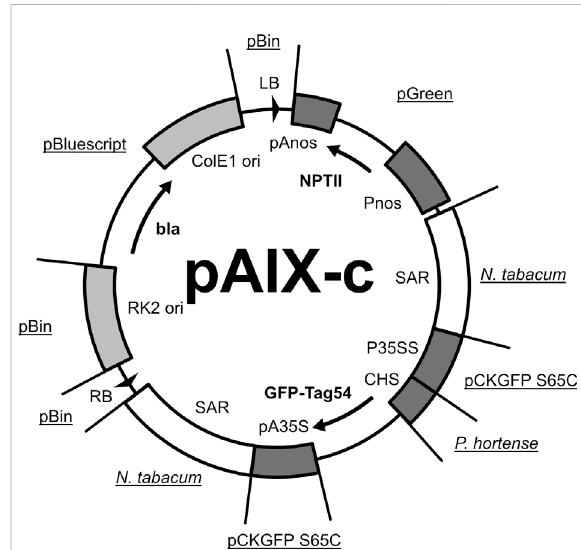
FIGURE 3 IllustrationofthepAIX-cbinaryvectoranditsfeatures.LB:left border of A. tumefaciens T-DNA; RB: right border of A. tumefaciens T-DNA; pAnos: polyadenylation sequence of the nopaline synthase of A. tumefaciens , Pnos: promotor of the nopaline synthase of A. tumefaciens ; SAR: scaffold attachment region of the RB7 gene from N. tabaccum ; P35SS: Promotor from Cauli fl ower mosaic virus ; CHS: 5 ′ untranslated region of the chalcone synthasegene from P. hortense ;pA35S: polyadenylation signal from Cauli fl ower mosaic virus ; ColE1 ori: Origin of replication from ColE1 plasmid ( E. coli compatible), RK2 ori: Origin of replication from RK2 plasmid ( A. tumefaciens compatible); NPTII: kanamycin resistance gene; GFP-Tag54: Green fl uorescent gene from Aquorea victoria with C-terminal 54k epitope tag sequencederivedfrom Tobaccomosaicvirus ;bla:beta-lactamase genefrom E.coli .Sources(plasmidsandorganisms)areunderlined (see Table